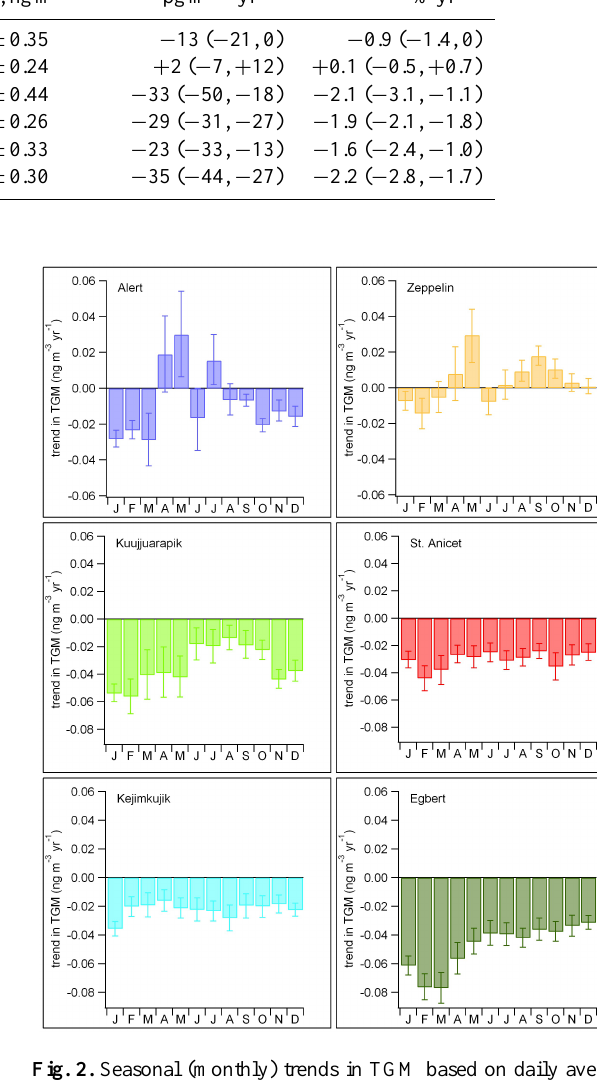
Table 2. Median, mean, and trends in TGM for 2000–2009, with 95% confidence range on trends. Site